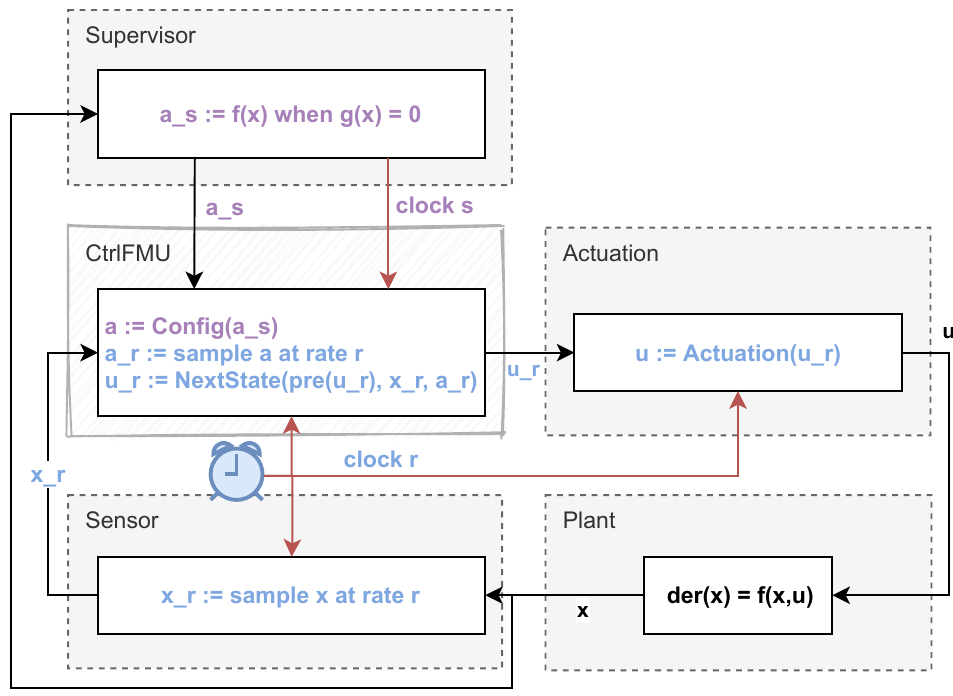
Figure 5. Clocked version of Figure